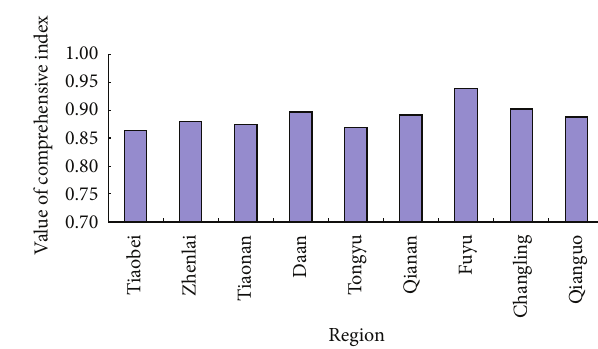
Figure 3: Assessment